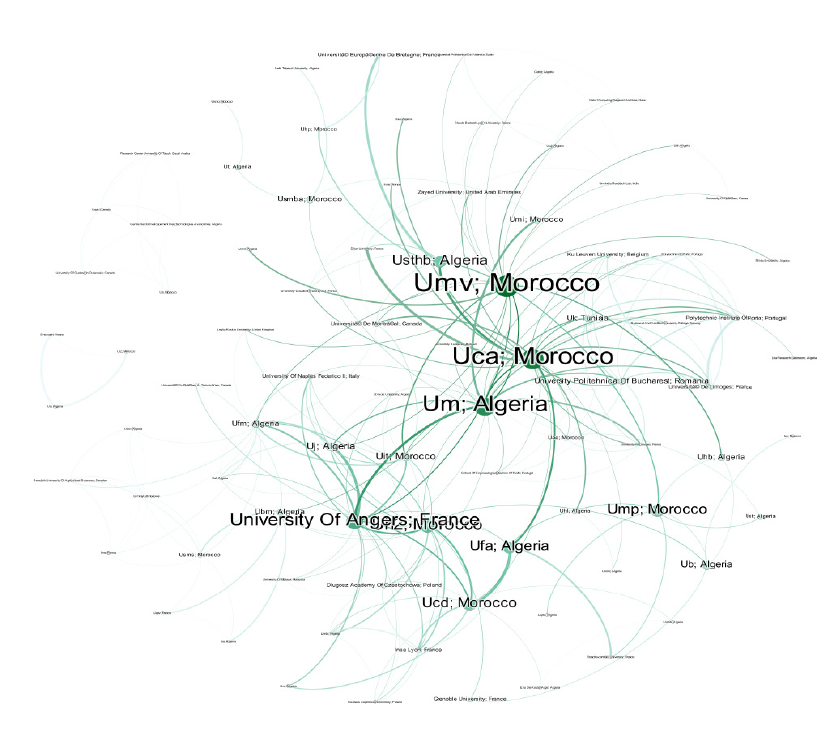
Fig. 3. Mapping of scientific collaboration between the affiliates of Morocco and Algeria in "computer Science" from 2007 to